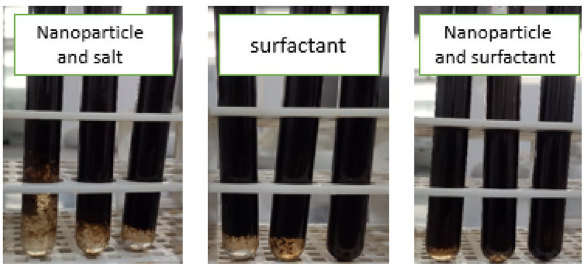
Figure 12. Emulsification after 10, 20, and 25 times shaking from left to